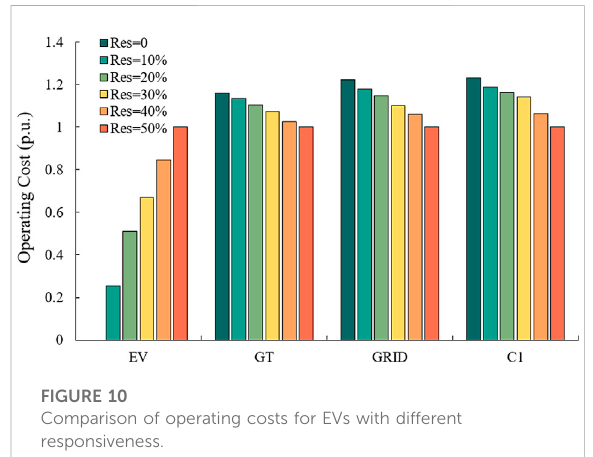
FIGURE 12 Comparison of the best Pareto Frontier for different